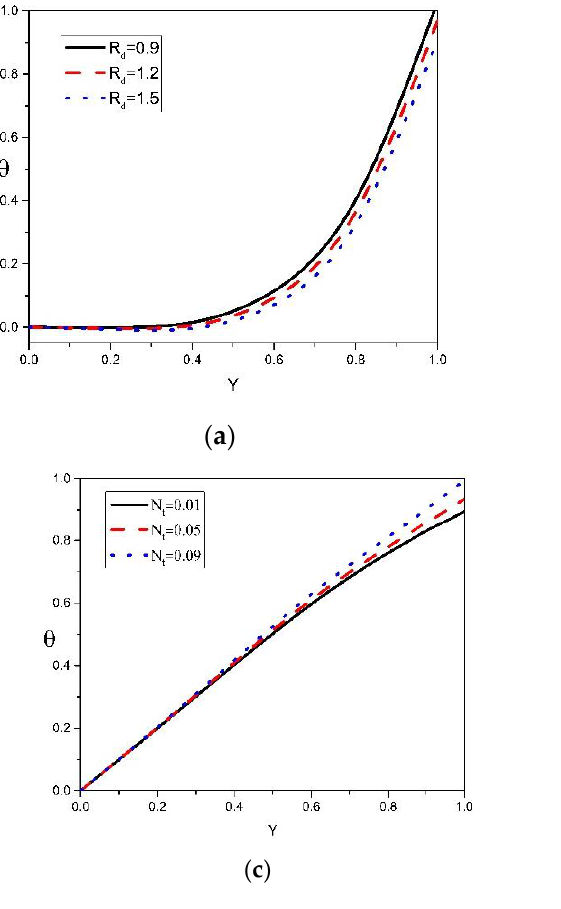
= 0.7, N = 0.7, N = 0.5, N t = 0.5, CT TC b